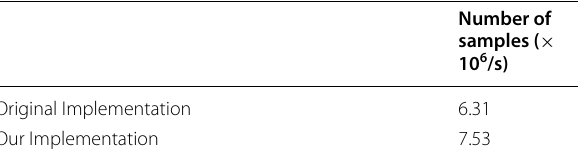
Table 2 Number of Gaussian samples of FALCON per second at